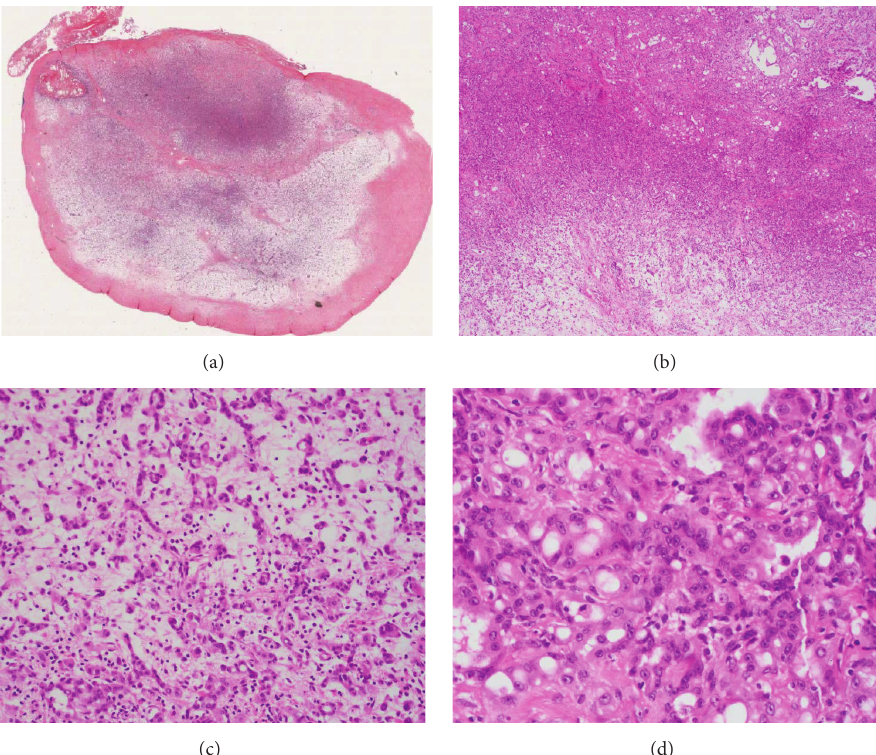
Figure 2: (a) The neoplasm was confined to a fibrous pseudocapsule. (b) Hypercellular and hypocellular areas were present. (c) and (d) The neoplasm grew as cords and luminal profiles and contained mildly pleomorphic nuclei with prominent